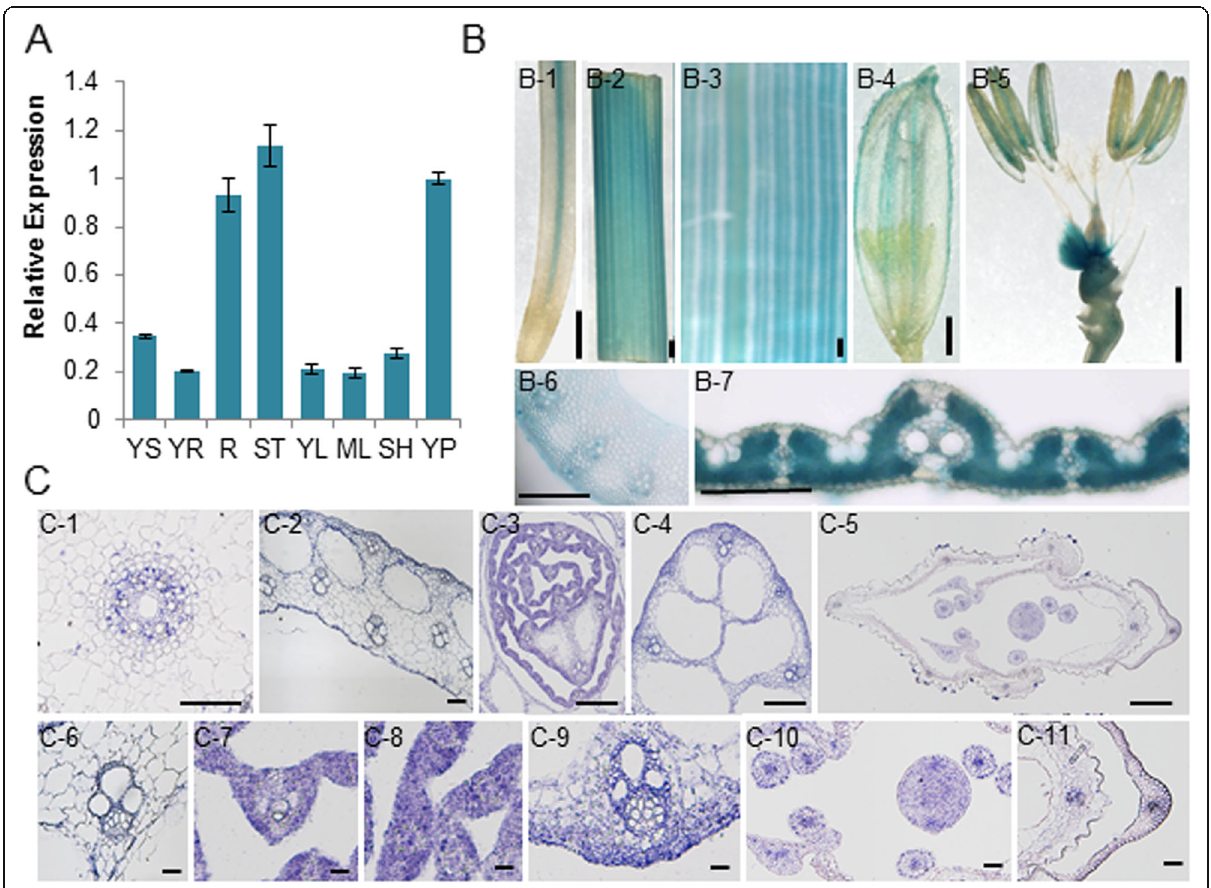
Fig. 5 Expression patterns of Z15. a Expression patterns of Z15 of the wild type in different tissues as indicated by quantitative real-time PCR. YS: leaf at seedling stage, YR: root at seedling stage; R: root, ST: stem, YL: young leaf, ML: mature leaf, SH: sheath, YP: young panicle. b GUS expression in various tissues of ProZebra15::GUS transgenic plants (B-1: root, B-2: stem, B-3: leaf, B-4: panicle, B-5: stamen, B-6 and B-7: hand cross-sections of stem and leaf. (B-1 to B-6: bar = 1 mm, B-7: bar = 25 μ m), c Expression patterns of Z15 indicated by in situ hybridization (C-1: root, C-2: stem, C-3: leaf, C-4: sheath, C-5: panicle, C-6 is an enlarged view of C-2, C-7 and C-8 are enlarged view of C-3, C-9 is an enlarged view of C-4, C-10 and C-11 are enlarged view of C-5, C-6 to C-11: bar = 100 μ